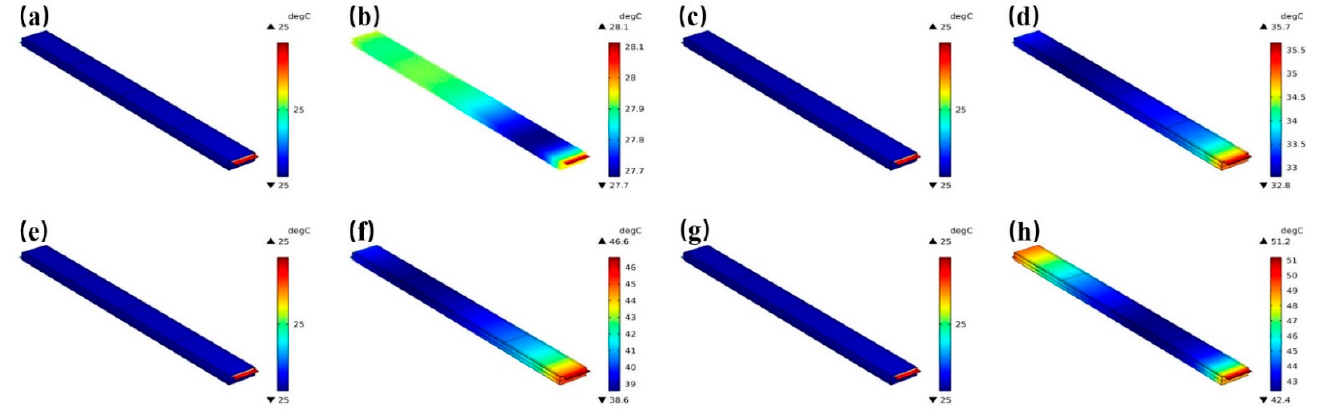
Figure 8. Results of the three-dimensional temperature distribution model for charging at 25 °C 0.5 C, 1 C, 1.5 C, 2 C. ( a , c , e , g ) charging initial moment; ( b , d , f , h ) charging cutoff